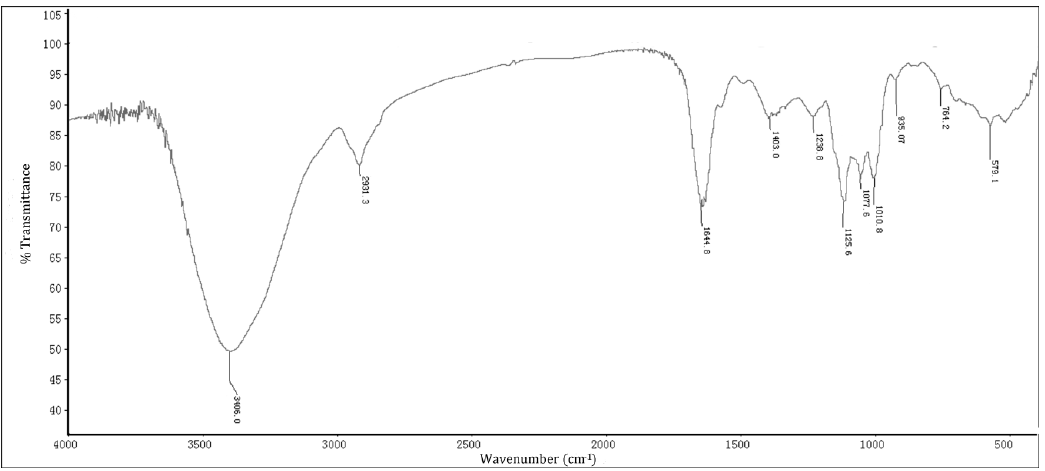
Figure 1. FTIR spectra of HP in the frequency range 4000–500 cm − 1 .